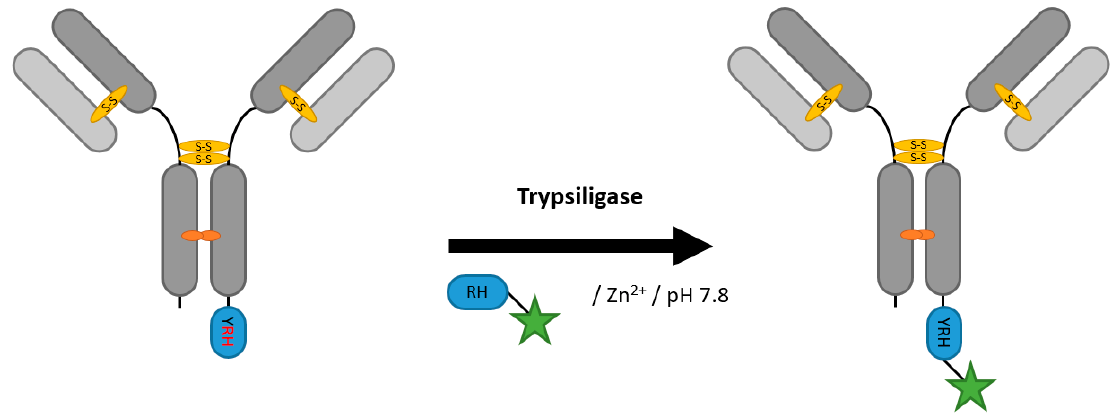
Figure 8. Scheme of an antibody modification by trypsiligase.